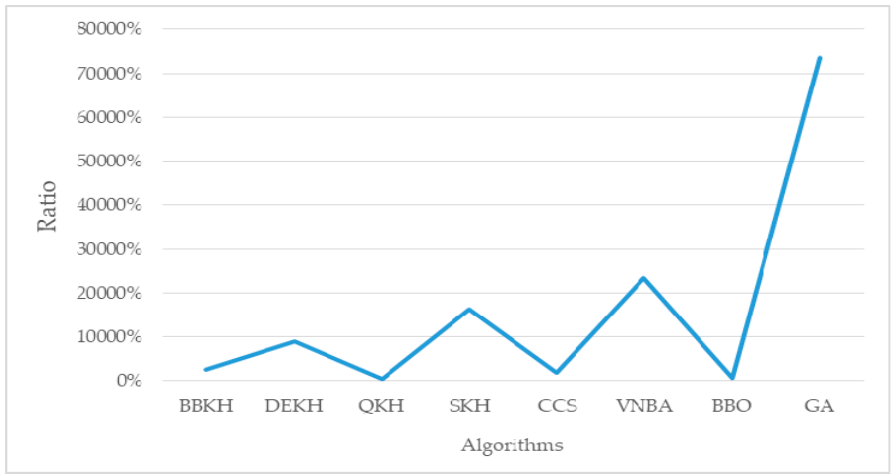
Figure 13. Ratio of AKQPSO over other algorithms in the first group.